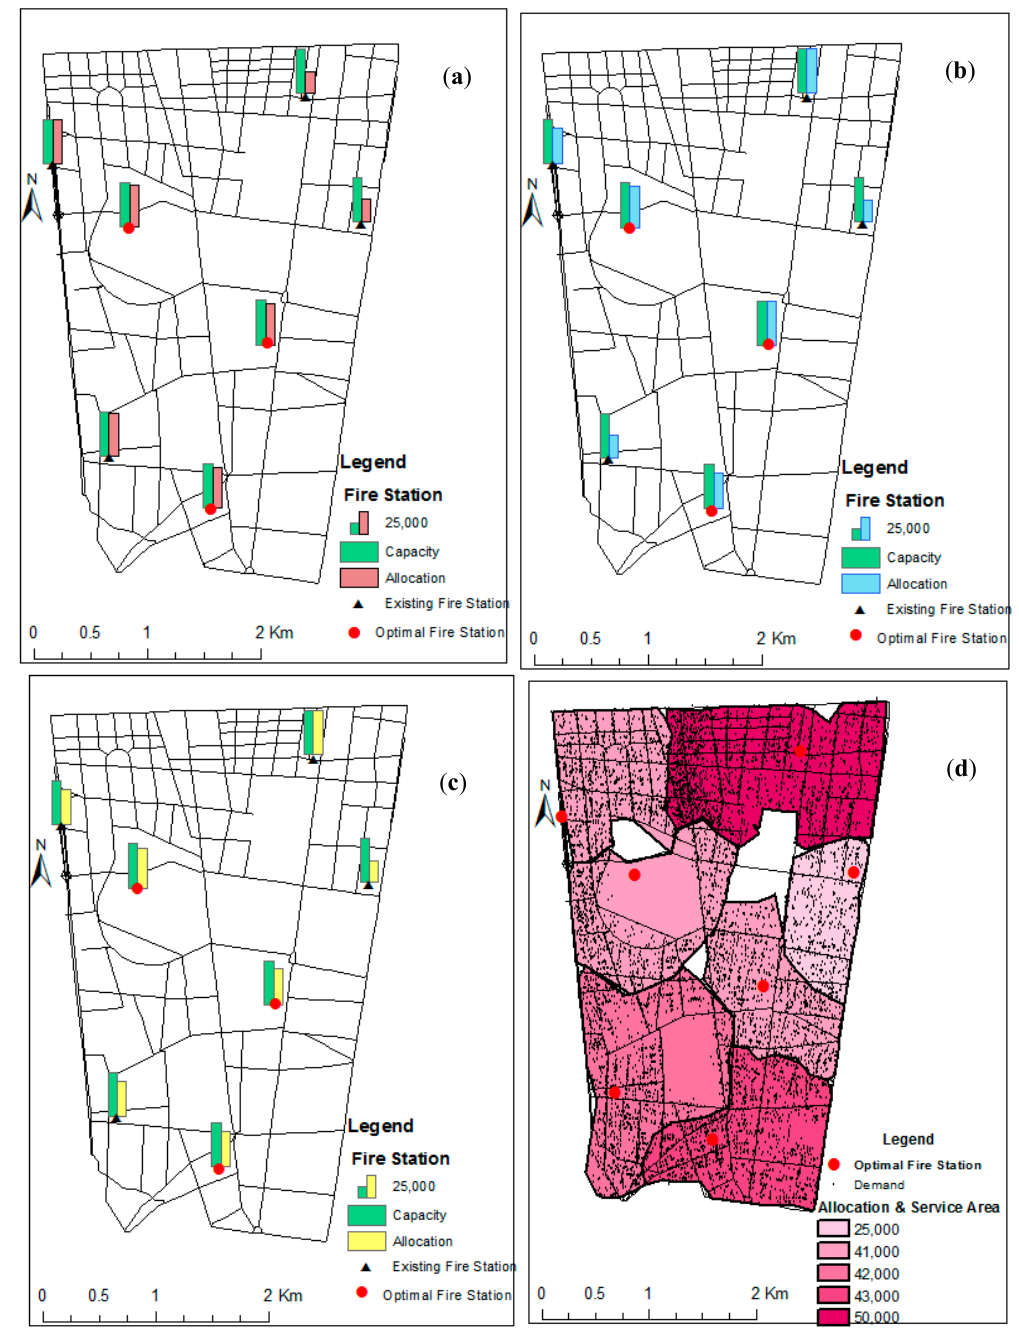
Figure 7. Optimal locations of the fire stations, obtained from capacitated multi-objective function with fixed weights ( W 1 = W 2 = W 3 = 0.3333 ) and demand allocations of ( a ) f1, ( b ) f2, and ( c ) f3; ( d ) the service areas of the individual fire stations.